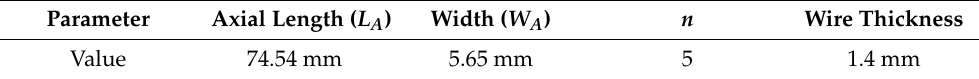
Table 2. Geometrical Parameters of the antennas.